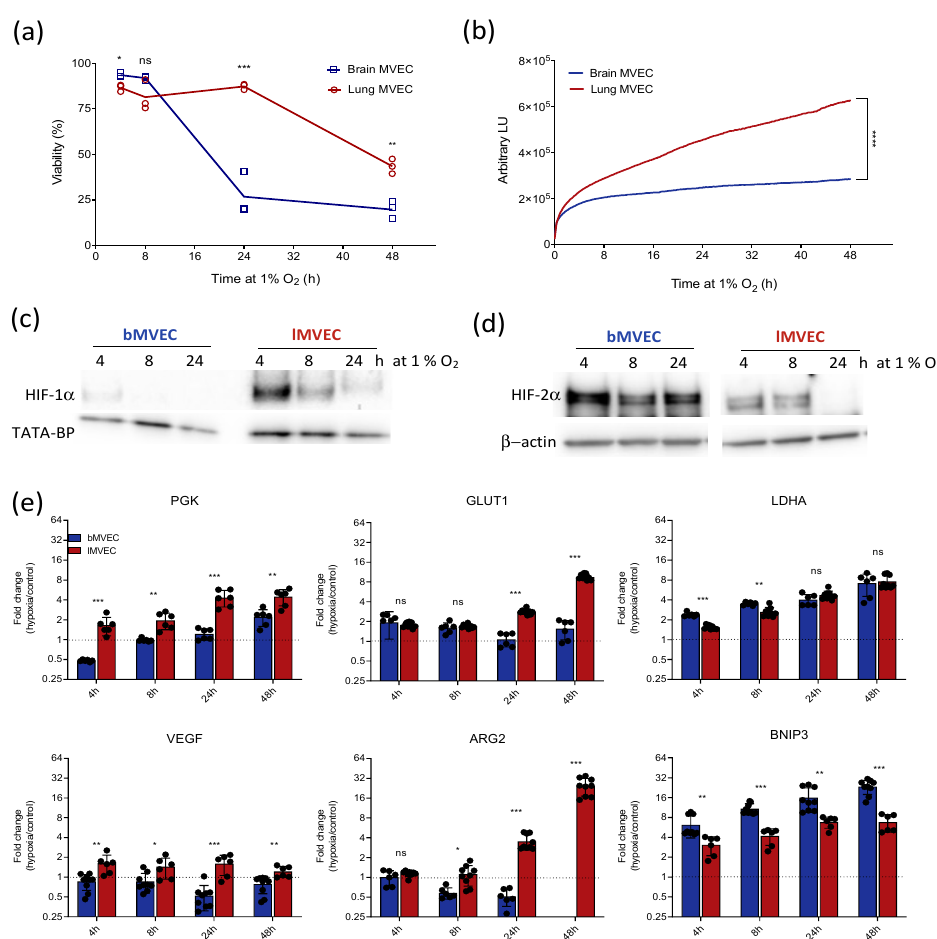
Figure 1. Lung and brain MVEC show organ-specific response and tolerance to hypoxia. ( a ) Viability of MVECs exposed to 1% O 2 at t = 0, measured by propidium iodide staining ( n = 3); t-tests corrected for multiple comparisons (Holm–Sidak) * p < 0.05, ** p < 0.01, *** p < 0.005), ns = not significant; ( b ) Real-time viability of brain and lung MVECs exposed to 1% O 2 at t = 0, measured using the Real-Time Glo Assay (Promega) ( n = 3). Shaded areas show SD, statistical differences were assessed by unpaired student’s t-test, using the area under the curve (**** p < 0.0001); ( c , d ) Western blot of HIF-1 α and HIF-2 α using nuclear extracts from brain and lung MVECs exposed to 1% O 2 for the indicated amount of time; loading control TATA-BP to show nuclear extracts used; b-actin used subsequently because more consistent across samples and replicates (see Figure S1); ( e ) RT-qPCR for hypoxia targets PGK , VEGF , GLUT1 , BNIP3 , LDH-A and HIF-2 α target ARG2 in brain and lung MVEC, at 21%, 10% or 5% O 2 baseline and after 1% O 2 . Average fold-change ± SD and individual readouts are shown (hypoxia/normoxia) ( n ≥ 3). t-tests corrected for multiple comparisons (Holm–Sidak), * p < 0.05, ** p < 0.01, *** p < 0.001; ns = not